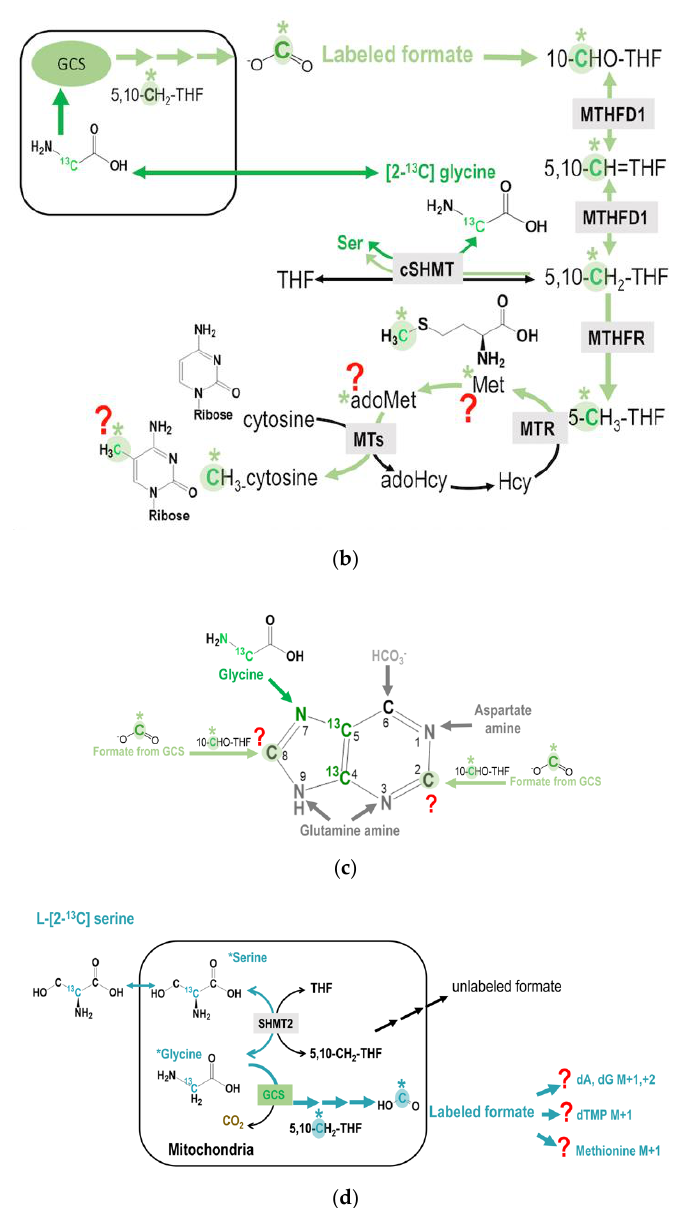
Figure 3. ( a ) the potential incorporation of C2-carbon of glycine into cytosolic serine and dTMP syntheses. The original glycine tracer is marked in green, and the recycled glycine 2-carbon from the GCS is marked in light green with a * mark. The M + 2 species of serine (Ser + 2) can only be detected when the GCS-derived formate from the C2-carbon of [2- 13 C]glycine is further used for the cytosolic serine synthesis from the [2- 13 C]glycine via cytosolic serine hydroxymethyl-transferase (cSHMT). On the other hand, the M + 1 species of deoxy-thymidine (dTMP, dT + 1) can only be detected when the GCS-derived formate from the C2-carbon of [2- 13 C]glycine is subsequently transferred to dUMP via methyleneTHF in the cytosol. ( b ) The potential incorporation of C2-carbon of glycine into transmethylation. The original glycine tracer is marked in green, and the recycled glycine 2-carbon from the GCS is marked in light green with a * mark. The GCS-derived C2-carbon from [2- 13 C]glycine may ultimately be incorporated into the methyl group of deoxy-cytidine in the DNA. ( c ) The potential incorporation of C2-carbon of glycine into the purine ring at C2 and / or C8. The original glycine tracer is marked in green, and the recycled glycine 2-carbon from the GCS is marked in light green with a * mark. ( d ) In the L-[2- 13 C] serine labeling experiments, any enrichment detected in M + 1 species of methionine and thymidine would solely reflect the mitochondrial 1C unit coming from the C2-carbon of serine (via mSHMT) and / or glycine (via GCS activity). The original serine tracer is marked in turquoise, and the recycled serine 2-carbon from the GCS is marked with a